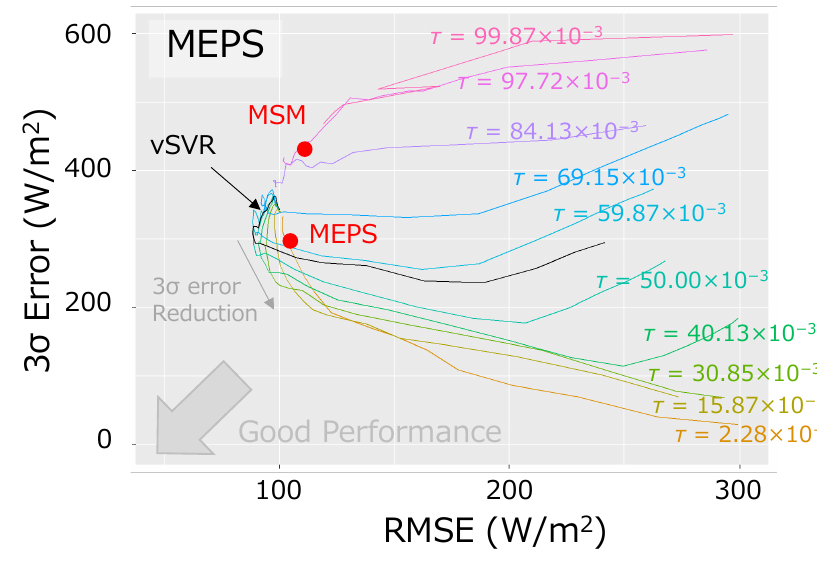
Figure 10. RMSE vs. 3 σ error for the MEPS- ν SVR and